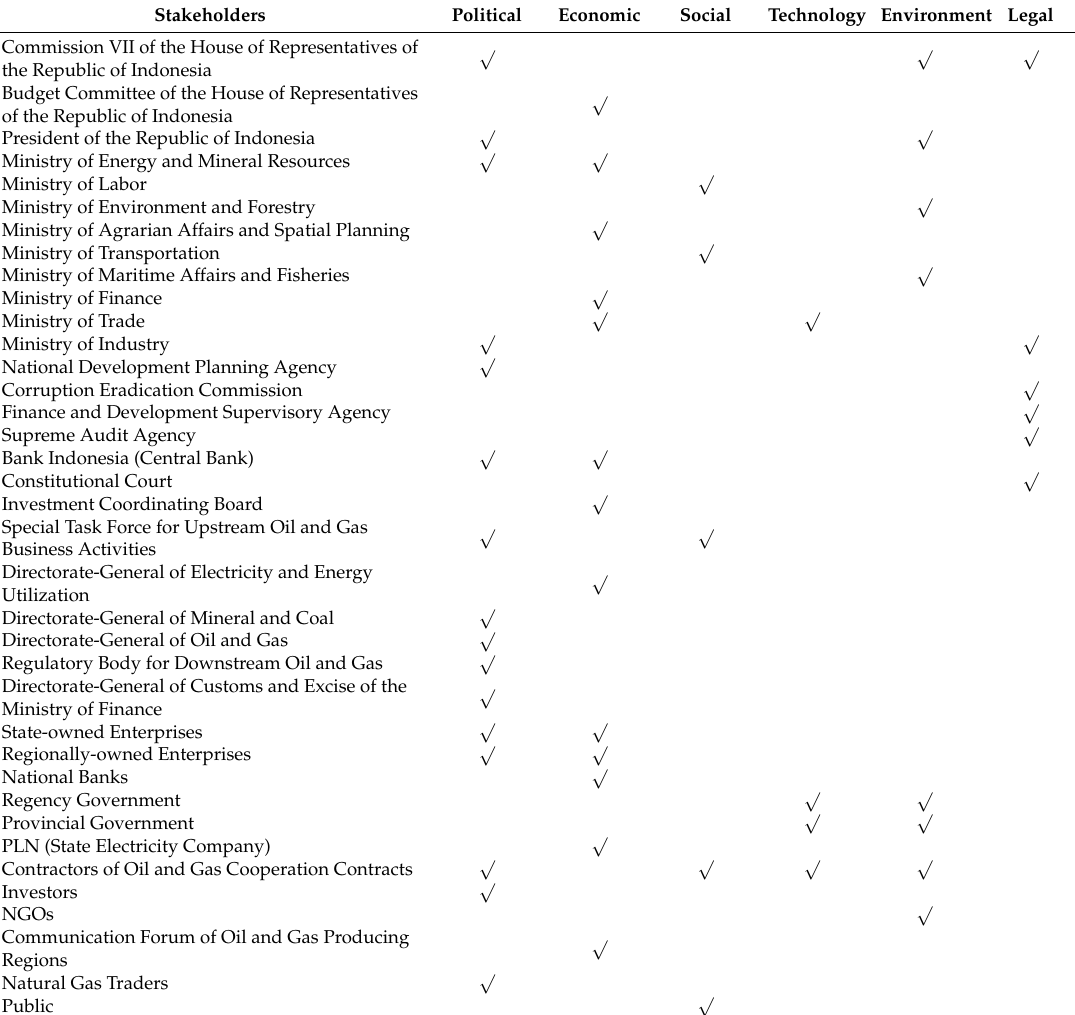
Table 1. Stakeholders of the fossil energy industry in